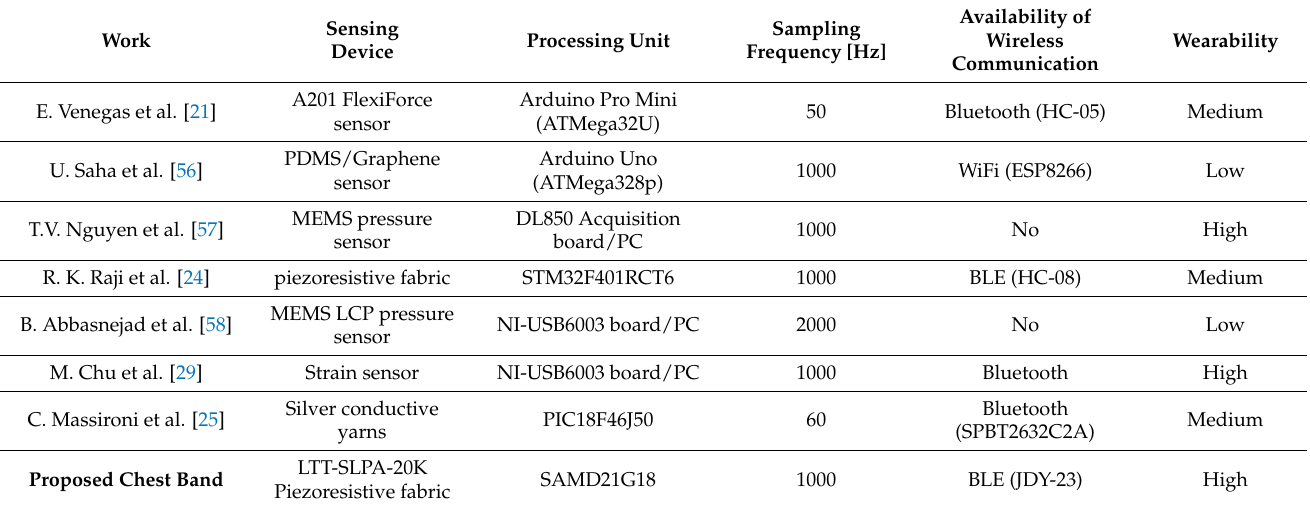
Table 5. Table summarizing the piezoresistive RR sensors from the point of view of the used sensing device, processing unit, sampling rate, availability of wireless communication, and wearability.